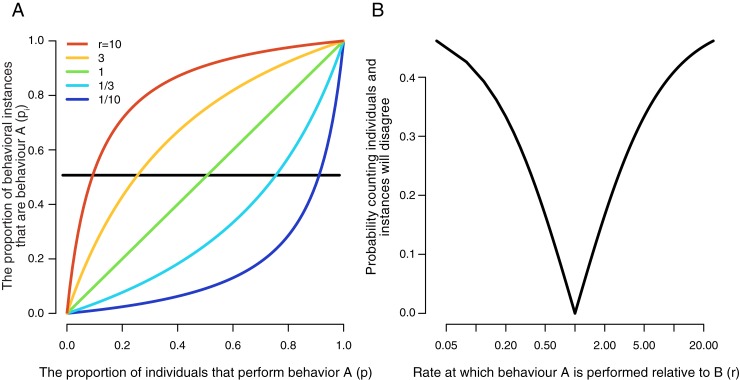
(A) As the proportion of individuals that perform behaviour A (p) increases so does the proportion of instances of a behaviour being performed that are behaviour A (pi). However, the rate of increase is strongly affected by the rate at which each individual performs behaviours A or B (r). When behaviour A is performed more frequently than behaviour B (r > 1) pi increases rapidly when p is low, but this soon slows down as p reaches moderately high values because pi approaches 1. When A is performed less frequently than B (r < 1) the increase in pi is slow at first, but once p reaches moderately high values it speeds up dramatically. (B) The probability that two observers who count individuals and instances, respectively, will disagree over which behaviour is in the majority is minimized when r = 1, but as r increases or decreases, the probability rapidly increases, slowing down as it reaches a maximum value of 1. Note the x-axis is logarithmic to make the symmetry around r = 1 more apparent.